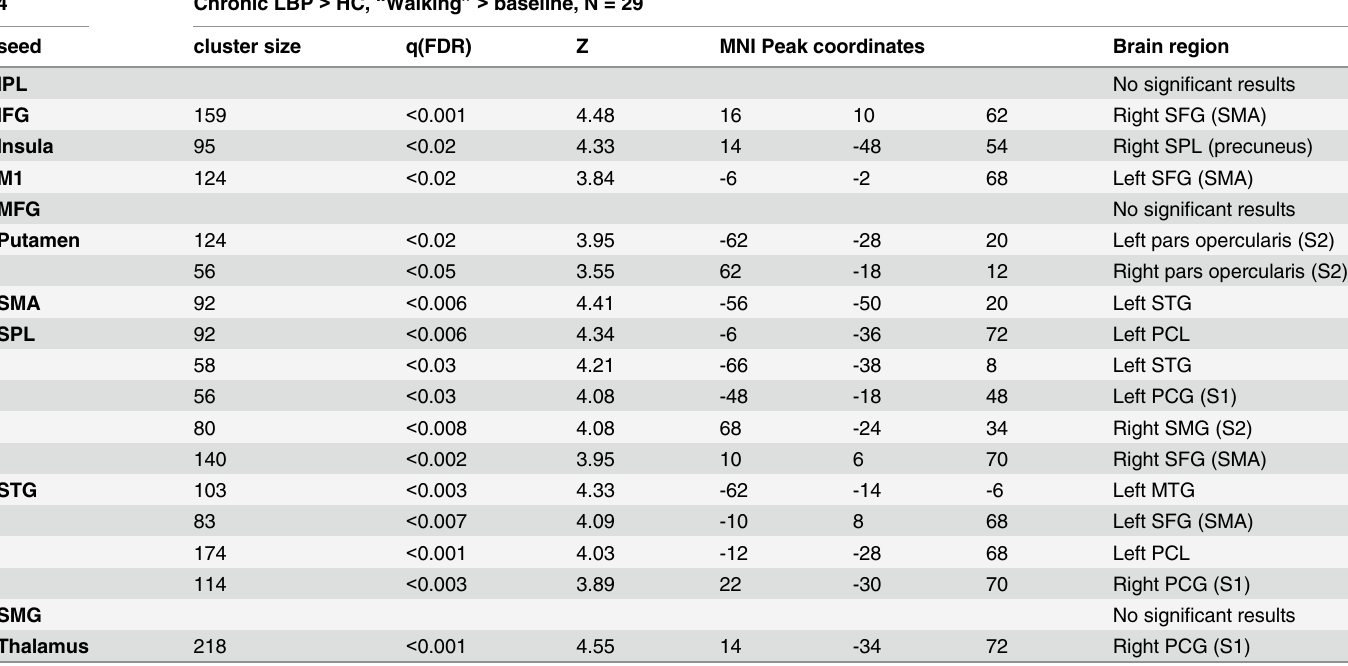
Table 4. Functional connectivity cluster maxima of the chronic Low Back Pain (LBP) group vs. healthy controls (HC), contrast walking activities ( “ Walking ” ). All results are false discovery rate corrected (FDR, q < 0.05). MNI = Montreal Neurological Institute, STG = superior temporal gyrus, ITG = inferior temporal gyrus, MTG = middle temporal gyrus, MFG = middle frontal gyrus, SFG = superior frontal gyrus, SMG = supramarginal gyrus, OL = occipital lobe, SPL = superior parietal lobule, IPL = inferior parietal lobule, PreCG = precentral gyrus, PCL = paracentral lobule, SMG = supramarginal